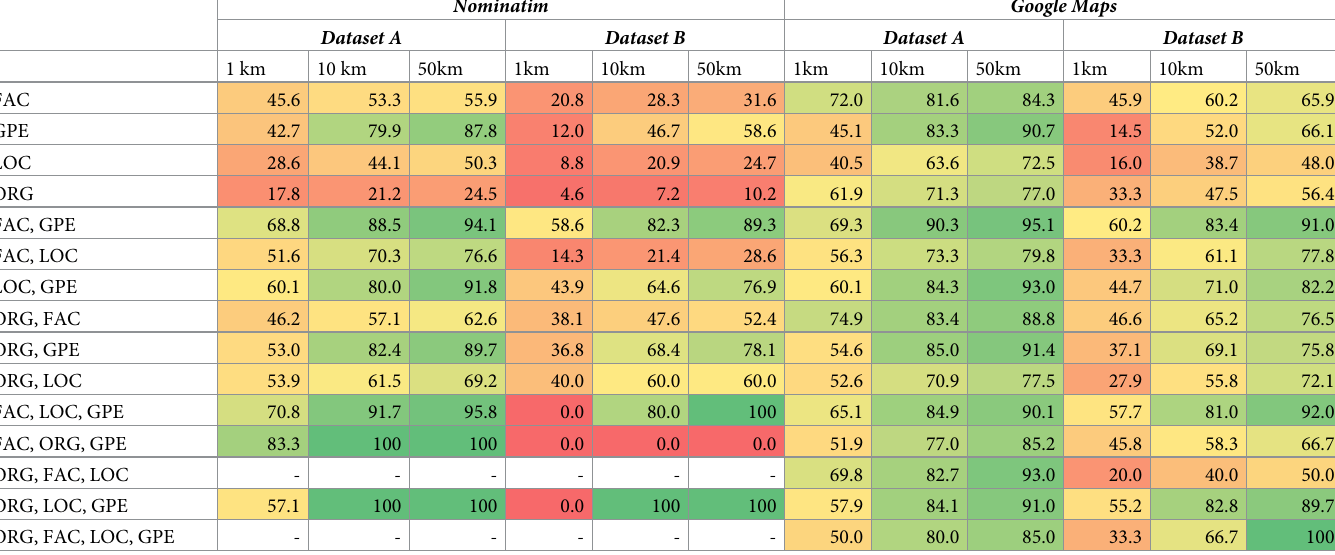
Table 6. Precision values of each geocoded location entity geocoded with Nominatim for Dataset A and Dataset B. The precision values are given for the 1 km, 10 km and 50 km displacement classes. Missing values indicate zero geocoded locations. The table is sorted alphabetically by location entities per each